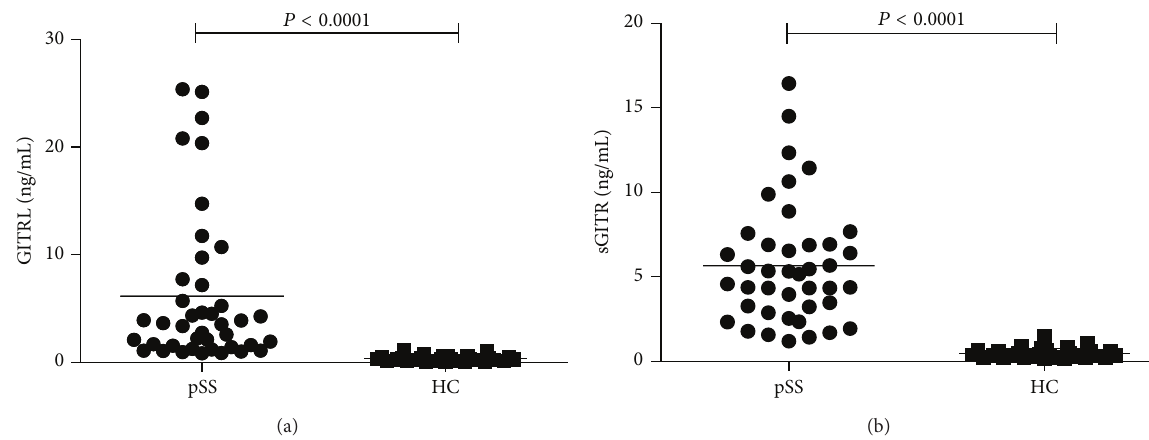
Figure 1: Comparison of serum GITRL and sGITR levels between pSS and HC. (a) Serum GITRL levels were significantly elevated in SS patients versus HC. (b) Serum sGITR levels were also significantly elevated in SS patients versus HC. Each symbol represents an individual patient and healthy donor. Horizontal lines indicate median values. GITRL: glucocorticoid-induced TNFR-related protein ligand; sGITR: soluble glucocorticoid-induced TNFR-related gene; SS: Sj¨ogren’s syndrome; HC: healthy control.